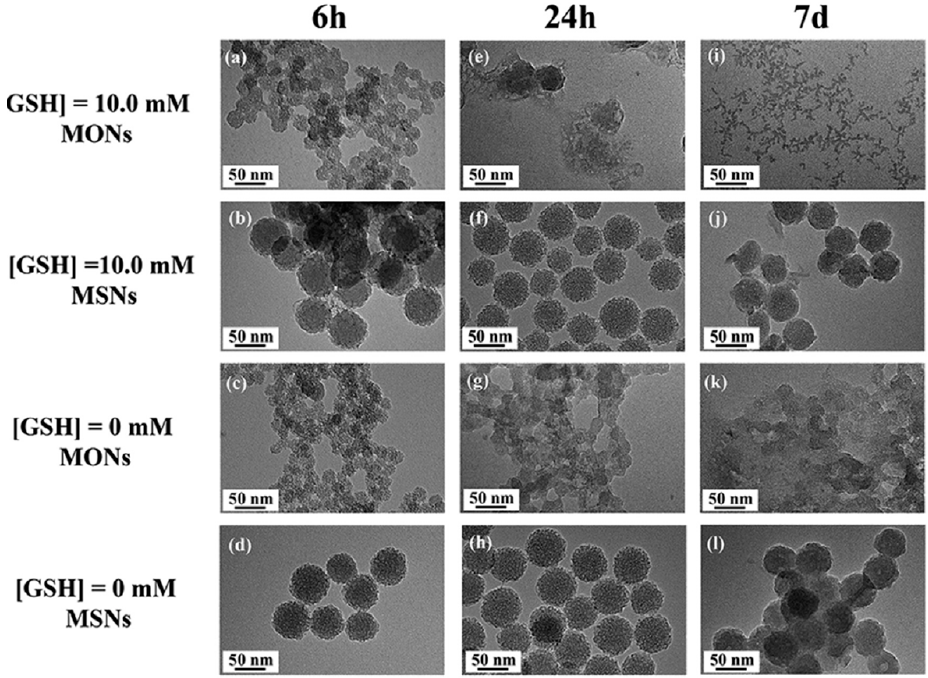
Figure 10. Representative example of the biodegradation by GSH of bridged (here denoted as MONs) vs. conventional MSNs. The different NPs were incubated in SBF solution in the presence or absence of 10 mM of GSH. As observed, conventional MSNs were nearly unaffected after 7 days, irrespective of the presence of GSH, whereas those containing disulfide bonds broke into tiny fragments in the reductive environment. Reproduced with permission from [63]. Copyright Elsevier, 2018.